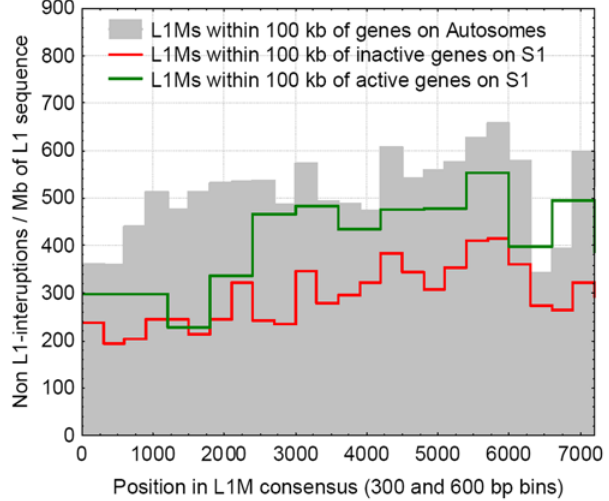
Figure 3. The frequencies of interruptions into L1Ms, within 100 kb of genes, for the genes that escape inactivation on the S1, are inactivated on the S1, and on the autosomes. L1Ms near genes escaping inactivation are interrupted at a higher frequency than near the inactivated ones, but at a lower rate than on the autosomes.